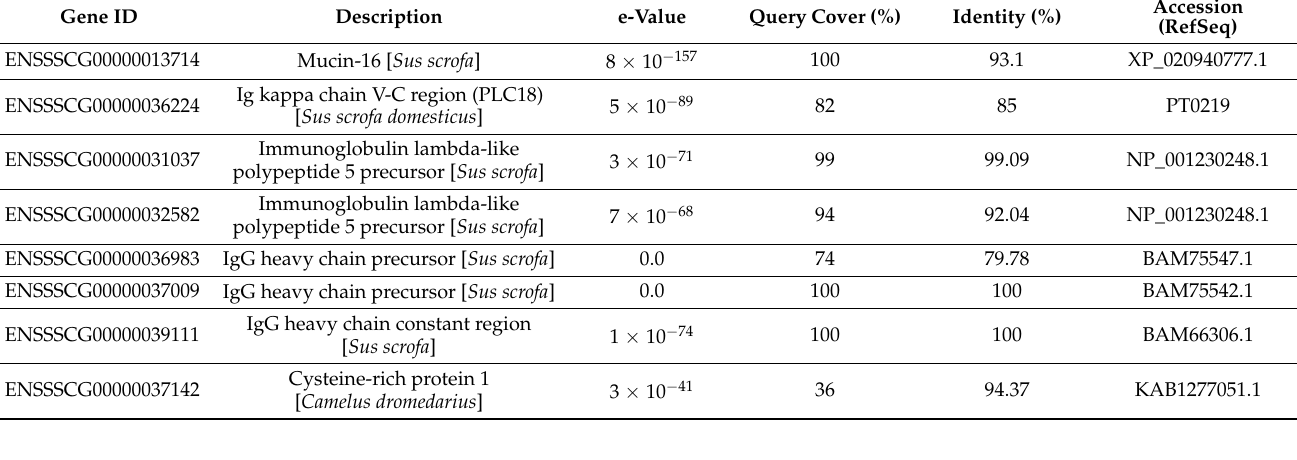
Table 3. Differentially expressed genes in the inguinal and umbilical ring annotated as uncharacterized protein.